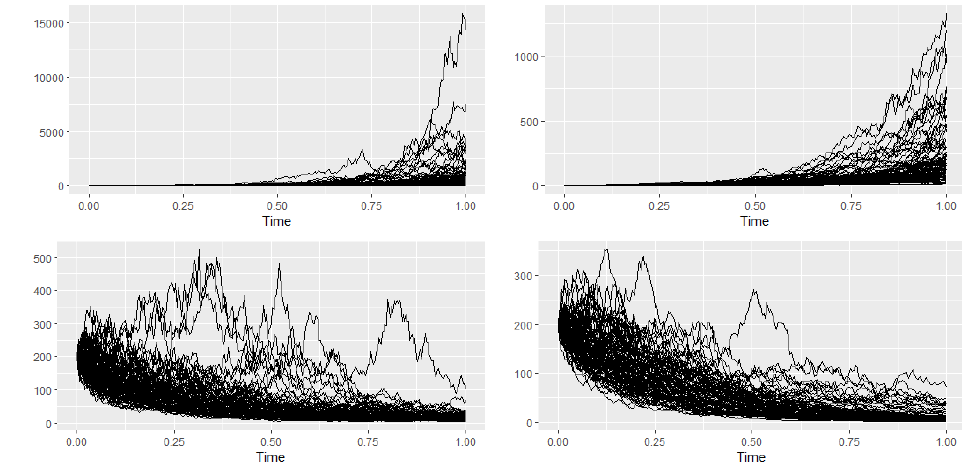
Figure 2. Sample trajectories of X t , with α = 0.9, λ = 3, X 0 = 2 ( up-left ), sample trajectories of GBM, with λ = 3, σ = 1, X 0 = 2 ( up-right ), sample trajectories of X t , with α = 0.9, λ = − 3, X 0 = 200 ( down-left ) and sample trajectories of GBM, with λ = − 3, σ = 1, X 0 = 200 ( down-right